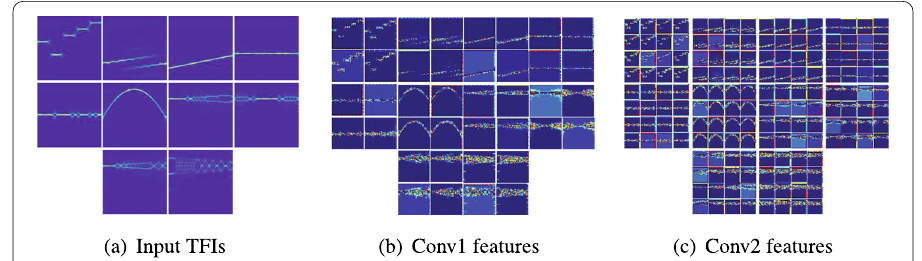
Fig. 6 Visualization of feature maps in different CNN layers. a The input TFIs with the size of 100 × 100 . b , c The output features of Conv Block 1 and Conv Block 2. The size of feature maps in b is 50 × 50 and 25 × 25 in